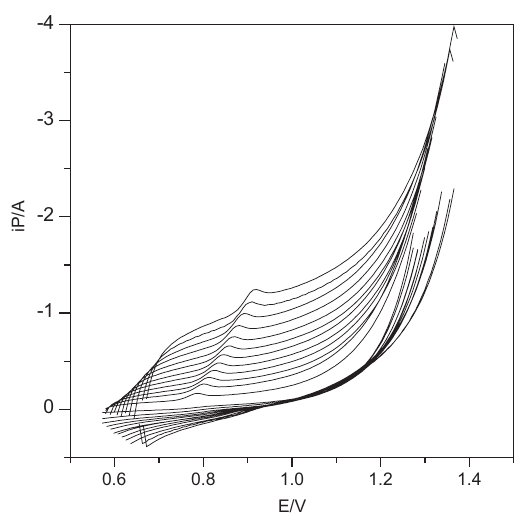
Figure 5 Cyclic voltammograms of GU on modifi ed electrode at different scan rate.